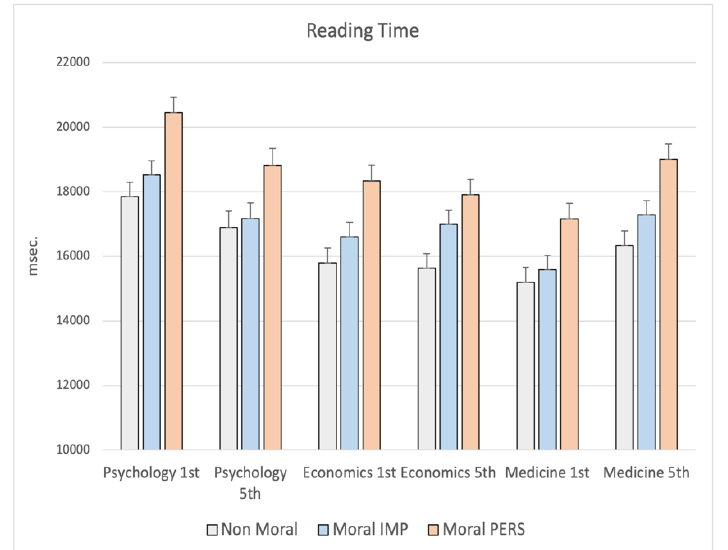
Figure 7. MANCOVA results on Reading Time: significant interaction school x year. Note: the y-axis shows the Reading Time (msec.).